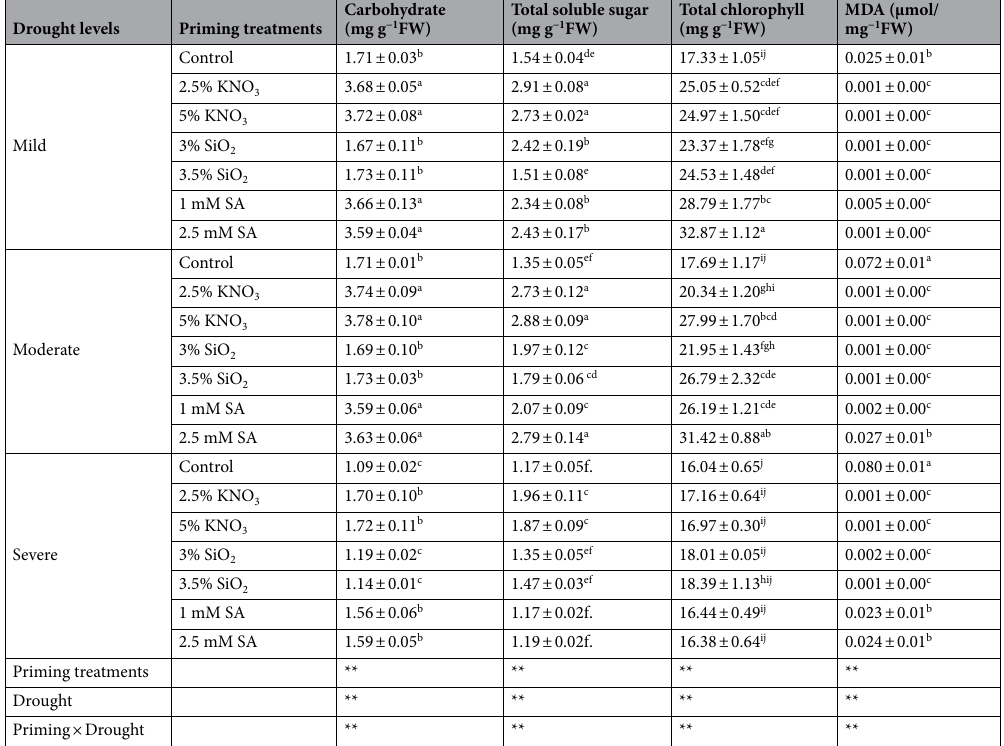
Table 5. Effects of KNO 3 , SiO 2 and SA priming on carbohydrate, total soluble sugar, chlorophyll and MDA contents of rice seedlings under drought conditions. Mean values ± SE in the same column followed with similar letters are not significantly different according to DMRT ( P ≤ 0.05); SE Standard error of the mean, DMRT Duncan’s multiple range test, *Significant at 5% level of probability, **Significant at 1% level of probability, ns Not significant, MDA